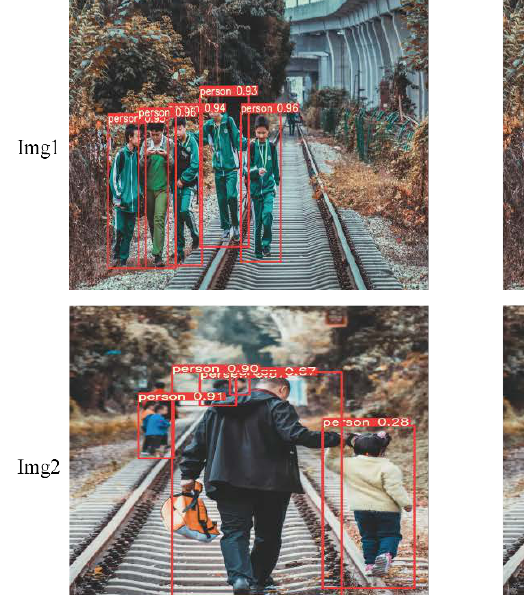
19 of 25 Figure 18. Comparison of training results of YOLOv5-AC and YOLOv4 and YOLOv5. The specific experimental index data are shown in Table 7. As can be seen from Table 7, the AP of improved YOLOv5-AC is 3.78% higher than that of YOLOv5s, and the Recall is 3.82% higher than that of YOLOv5s. At the same time, compared with other mainstream algorithms, such as YOLOv4, Efficientdet, etc., the advantages in parameters, such as the number of parameters, floating-point calculation amount, and FPS, are even more obvi- ous. Table 7. Comparison of YOLOv5-AC and other models’ performances.